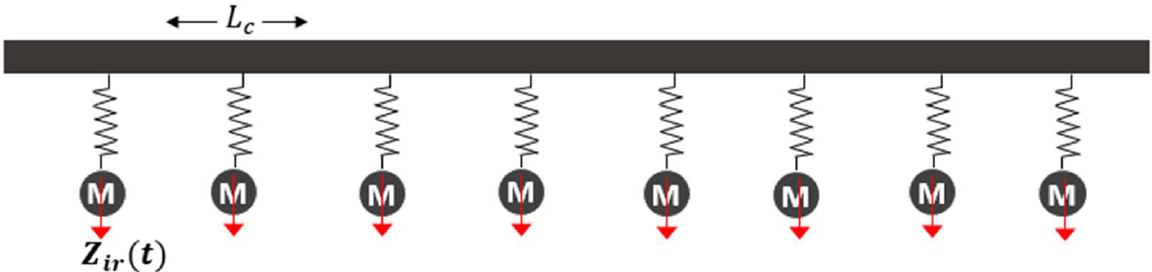
Figure 1. Schematic representation of a single-beam metamaterial structure. M represents the mass of the local resonators, while Z ir is the displacement of the local resonator. The local resonators of the single-beam metamaterial structure in Figure 1 are further represented in the form of stiffness and damping shown in Figure 2. The symbols U ( x , t ) , ξ r , and k r represent the displacement of the beam, the damping coefficient of the local resonator, and the stiffness,